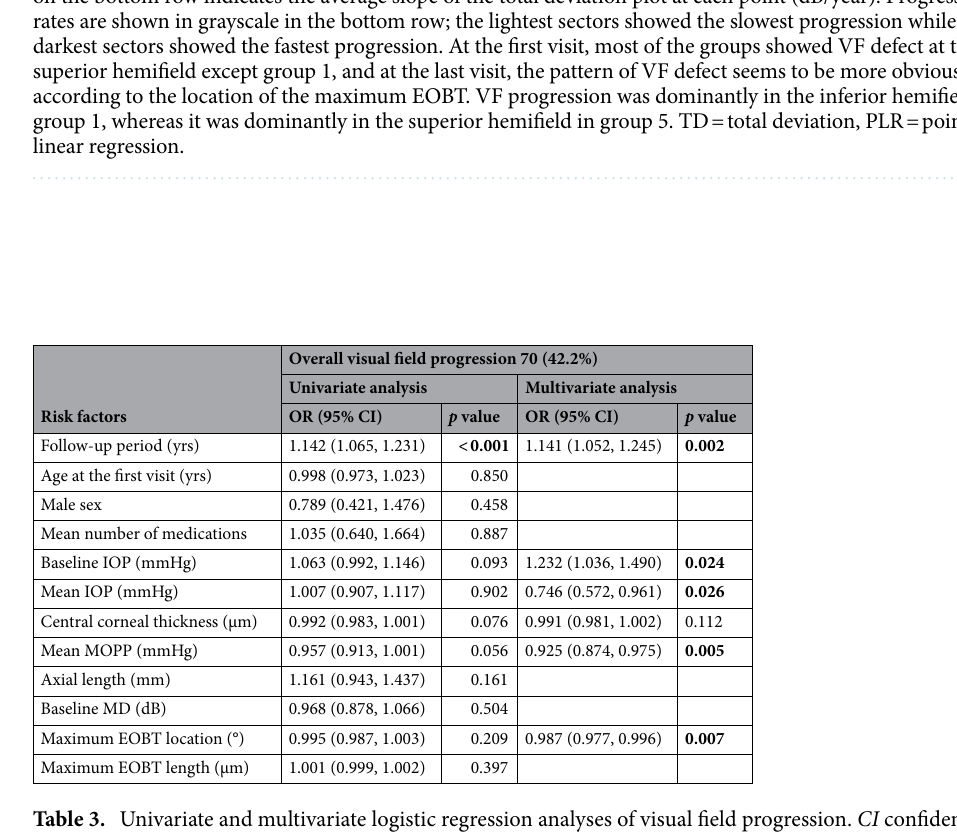
Table 3. Univariate and multivariate logistic regression analyses of visual field progression. CI confidence interval, EOBT externally oblique border tissue, IOP intraocular pressure, MD mean deviation, MOPP mean ocular perfusion pressure. The best multiple logistic regression model was chosen based on the Akaike Information Criterion. Factors with statistical significance are marked in bold.